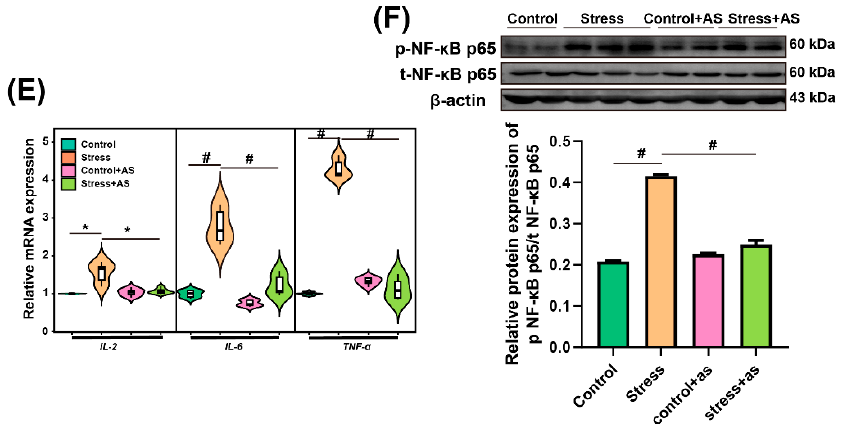
Figure 8. β 2 -AR activates FOXO1 and FOXO1 induced the expression of p-NF- κ B p65/t-NF- κ B p65 protein and its downstream inflammation genes. These protein bands of β 2 -AR, FOXO1, p-NF- κ B p65, and t-NF- κ B p65 in ESCs were tested by adding agonist and blocking agents ( A ). The protein levels of β 2 -AR increased after adding the agonists of β 2 -AR compared with the control cells ( B ). Interestingly, the protein levels of FOXO1 were obviously increased when β 2 -AR was activated but were significantly decreased when Butox was added to the cultured cells ( C ). It is worth noting that the protein expression of p-NF- κ B p65/t-NF- κ B p65 did not change when β 2 -AR was activated, but it increased when β 2 -AR was blocked by Butox, and it decreased significantly when FOXO1 was inhibited by AS1842865 ( D ). ( E ) The mRNA levels of IL-2, IL-6, and TNF- α in the uterus of pregnant mice at P5 after restraint stress and adding AS. ( F ) Protein band and quantitative analysis of p-NF- κ B p65/t-NF- κ B p65. Formoterol hemifumarate (For) is a selective agonist of β 2 -AR. Butox is the blocking agent of β 2 -AR, and AS1842865 is an inhibitor of FOXO1. Pyrrolidine dithiocarbamate ammonium (PDTC) is an inhibitor of NF- κ B. DMSO is the solvent for the drugs. These data are expressed as the mean ± SEM. * p < 0.05 and ** p < 0.01 were used to denote the significance of the other groups compared with the corresponding control group ( B ). ++ p < 0.01 were used to denote the significance of other groups compared with the corresponding For group. $ p < 0.05 was used to denote the significance of other groups compared with the cell+For+Butox+AS group. Independent sample t test was performed, * p < 0.05 and # p < 0.01 were used to denote the significance of the stress group compared with the corresponding control group ( E and F